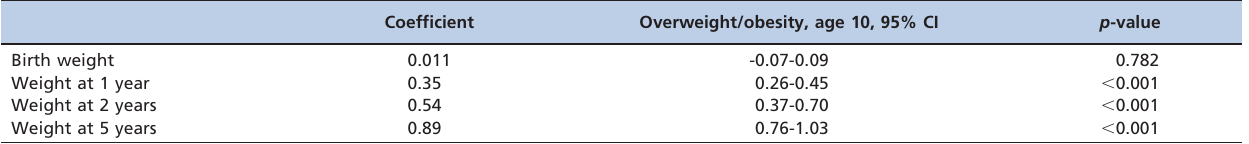
Table 3 - Linear multiple regression to test the independent association between weight at each age (transformed into conditional weight variable) and later